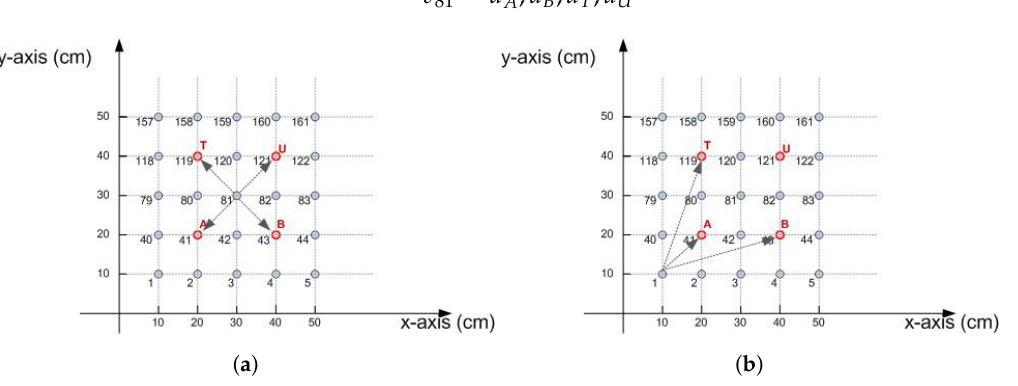
Figure 12. Estimation of positions. ( a ) A receiver is at the same distance from four candidate points of the training mesh; ( b ) Possible estimation errors.